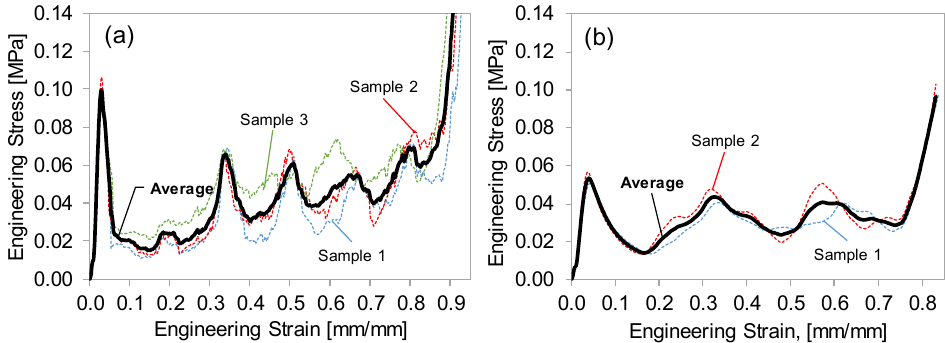
Figure 4. Stress–strain curves for all the individual (dashed) 3 × 3 × 3 R0.5 lattice tests. The bold curve represents the average response ( a ) Resin 1, three samples. ( b ) Resin 2, two samples.